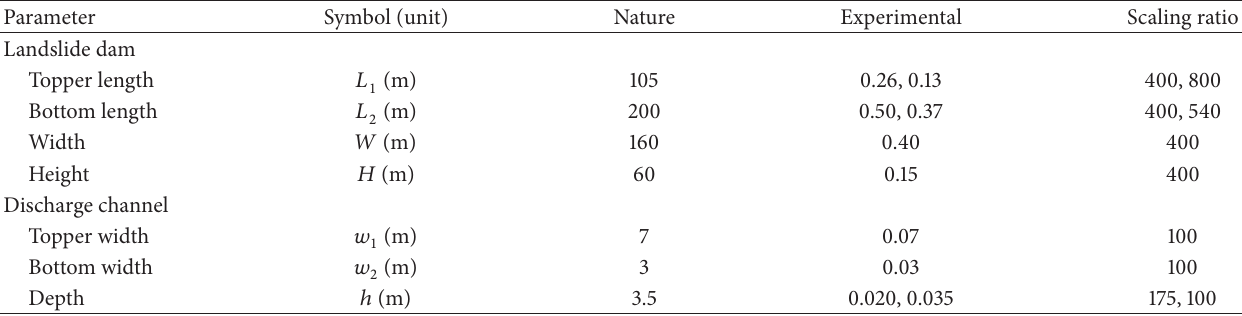
Table 2: Scaling ratio between the natural dam and experimental dam.